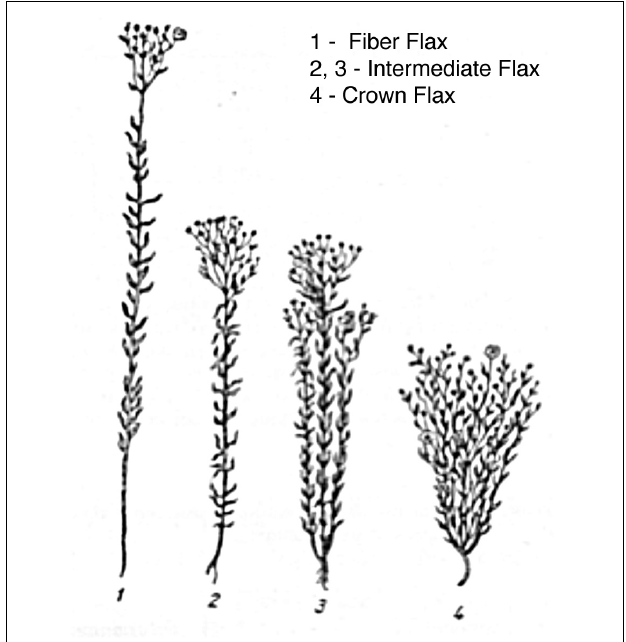
FIGURE 1 | Flax morphotypes. Sketch of flax morphotypes, where intermediate and crown flax cartoons represent oilseed